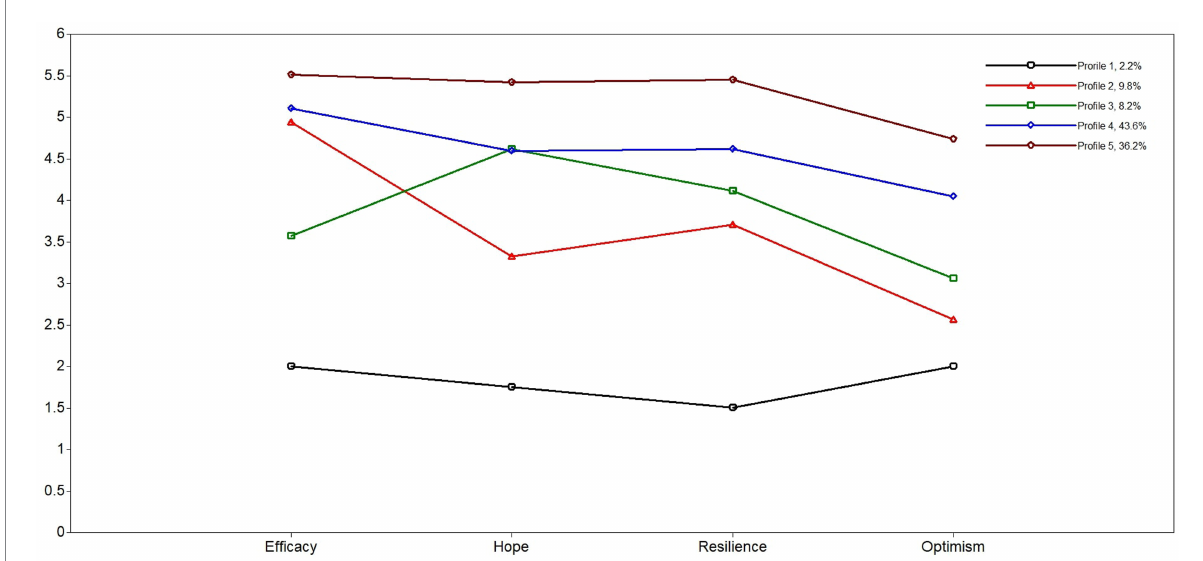
FIGURE 2 Latent profiles of PsyCap dimensions at T1 and the profile percentages. Profile 1: Low PsyCap ; Profile 2: Dominant Efficacy PsyCap ; Profile 3: Dominant Hope PsyCap ; Profile 4: Moderate High PsyCap ; Profile 5: High PsyCap .